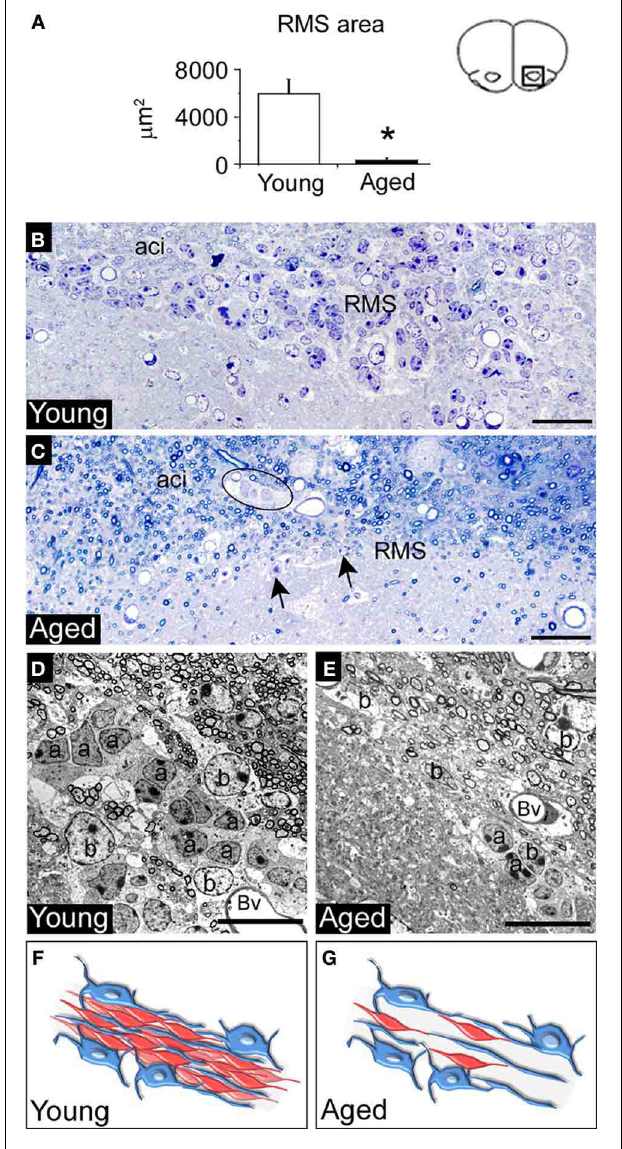
FIGURE 2 | Cytoarchitecture of aged RMS reveals a loss of migrating neuroblasts into the gliotubes. Analysis of the RMS by using light and electron microscopy. (A) Bar graph depicting a significant reduction of the area occupied by the RMS in aged mice. (B) Semithin section of the young RMS showed multiples chains of neuroblasts. (C) Semithin section of the aged RMS showed a notable loss of migratory chains, but dispersed cells remained (arrows). Note the presence of groups of neuroblasts and astrocytes within the intrabulbar part of the anterior commissure (delineated). (D) Electron microscopy image of a young RMS showing a detail of the neuroblasts chains surrounded by astrocytic gliotubes. (E) Electron microscopy image showing a detail of the aged RMS, where neuroblasts were severely reduced. (F) Schematic representation of the RMS cytoarchitecture in young mice. Chains of neuroblasts (red) migrating through gliotubes, which were formed by astrocytes (blue). (G) Schematic representation of the RMS cytoarchitecture in aged mice. Note the loss of neuroblast migrating through the gliotubes. a, neuroblast; aci, intrabulbar part of the anterior commissure; b, astrocyte; Bv, blood vessel. Scale bar: B,C = 20 µ m, D,E = 10 µ m. ∗ p < 0 .